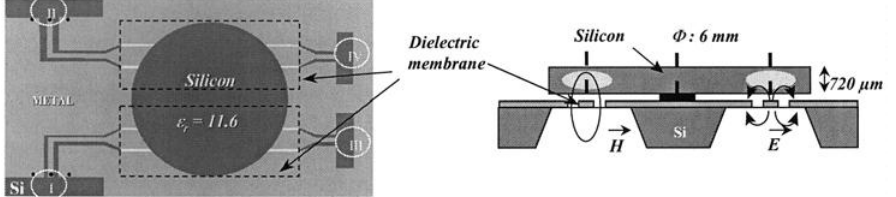
FIGURE 5 Topology of the silicon micromachined cavity in the 95GHz